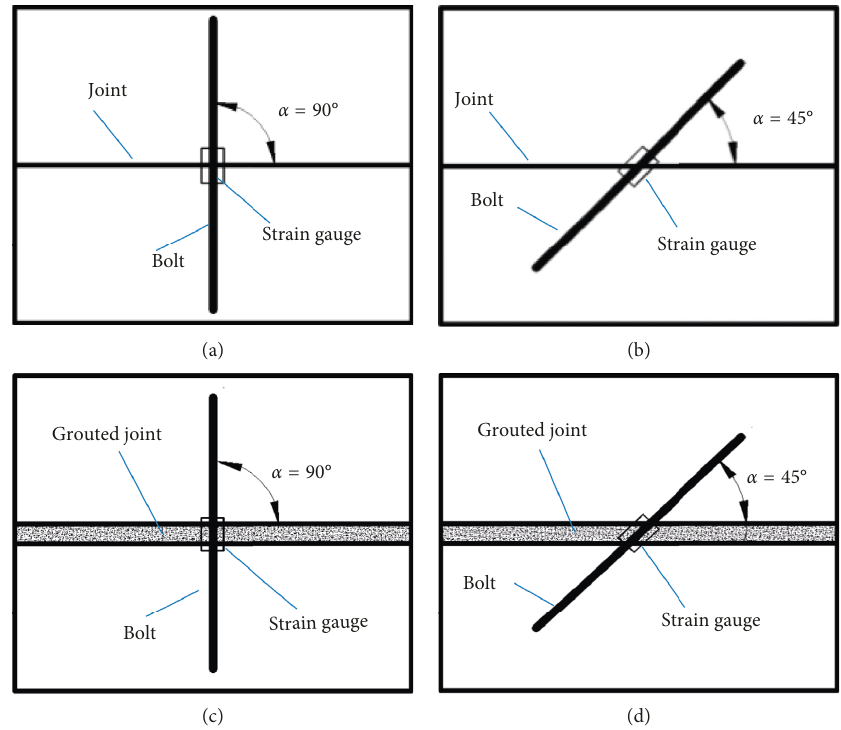
Figure 1: Schematic of the sample. (a) 90 ° and (b) 45 ° bolted nonfilled joints. (c) 90 ° and (d) 45 ° bolted grouted joints.